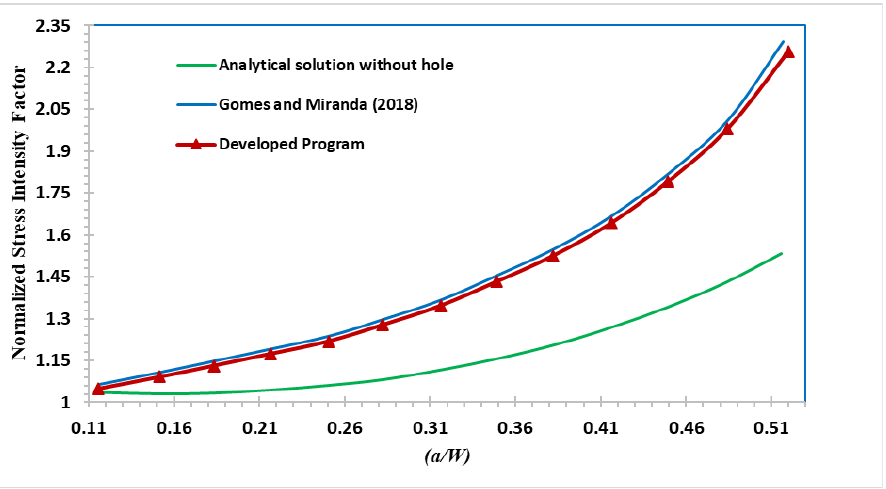
Figure 18. Normalized SIFs for the regular and modified four-point bending beam compared to Gomes and Miranda [27].